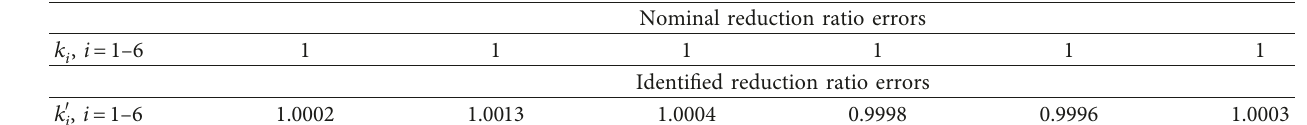
Table 4: Nominal and identified value of reduction ratio errors.